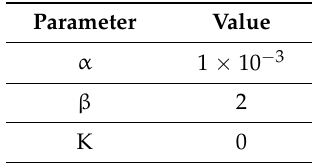
Table 7. UKF tuning